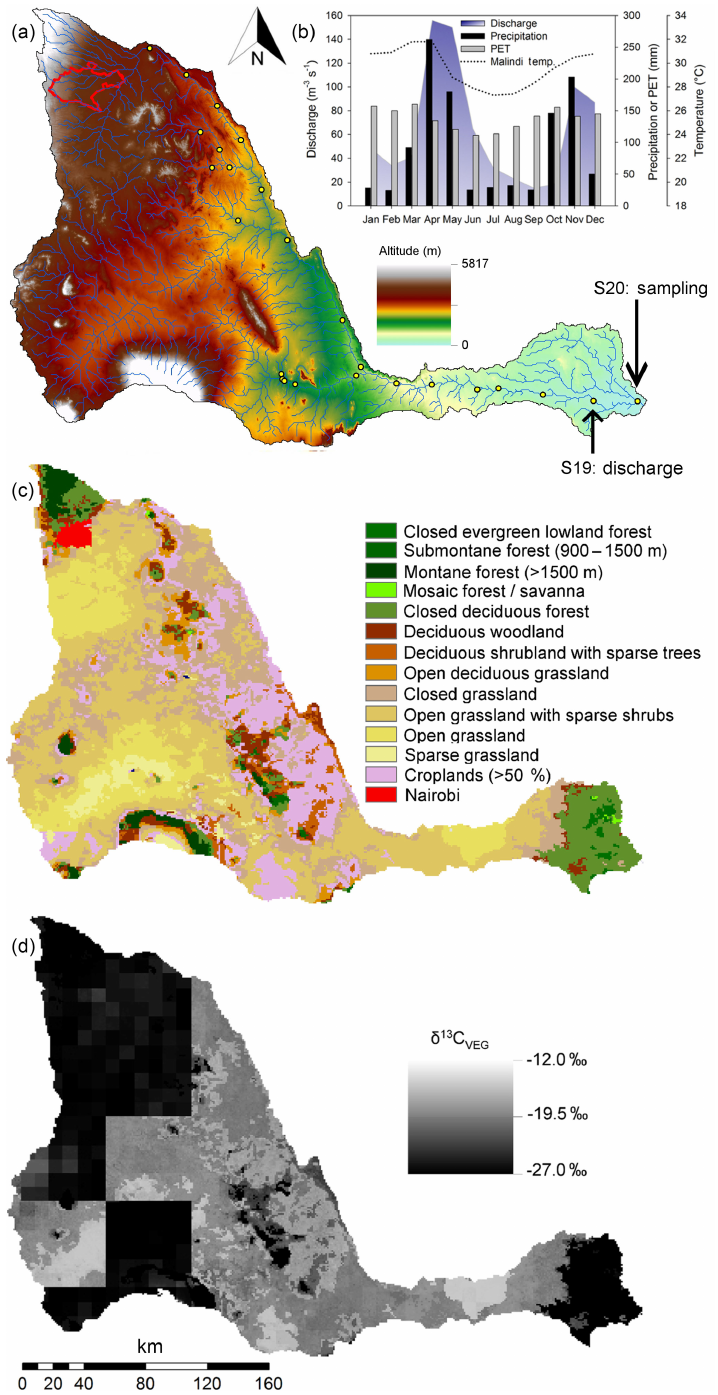
Figure 1. The Athi–Galana–Sabaki River basin: (a) digital elevation model; (b) mean monthly variation of hydrological and climate param- eters including discharge at the outlet (shaded area; data from 1959–1977), precipitation (black bar; from Fleitmann et al., 2007), potential evapotranspiration (PET; grey box) and the maximum air temperature in Malindi (A-G-S outlet; dotted black line); (c) GLC2000 vegetation biomes (Mayaux et al., 2004); (d) crop-corrected vegetation “isoscape” (extracted from Still and Powell, 2010). The yellow dots in (a) mark the site locations from Marwick et al. (2014a), with the locations of biweekly sampling here (S20) and discharge data collection (S19) indicated, while the area of Nairobi is highlighted by the red outline in the upper